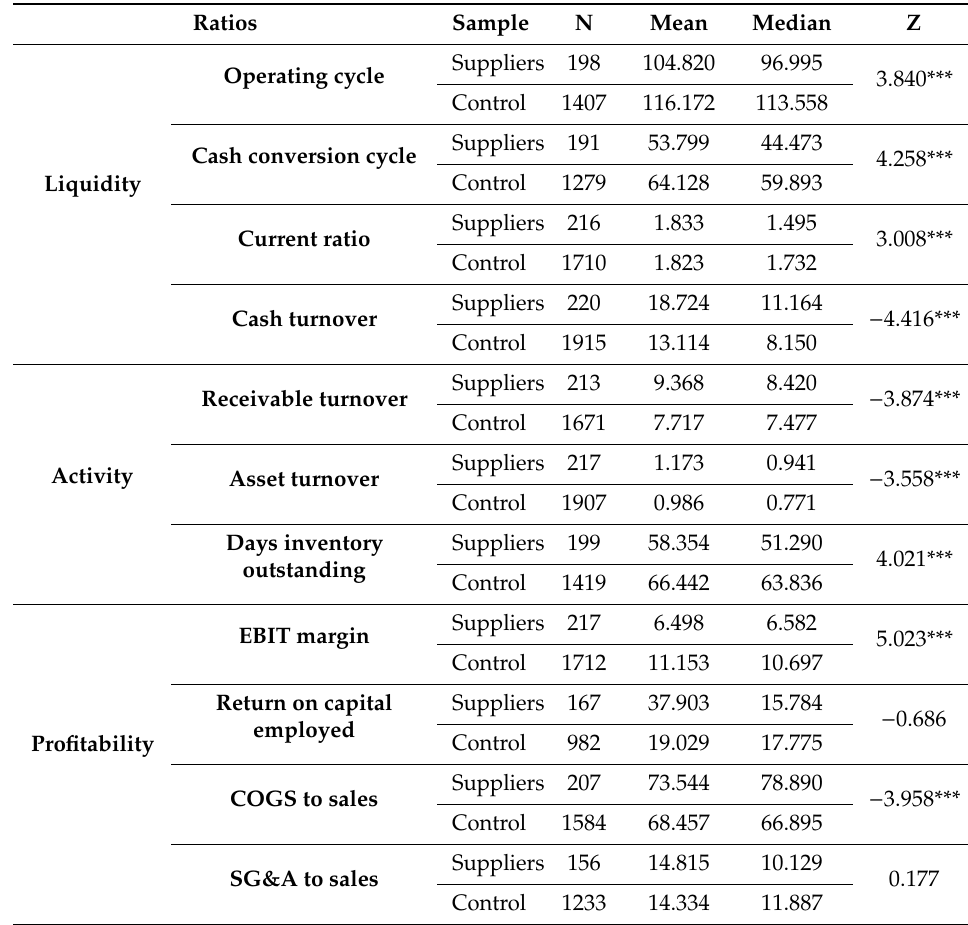
Table 5. Comparison of ratios for suppliers of SCLs and control